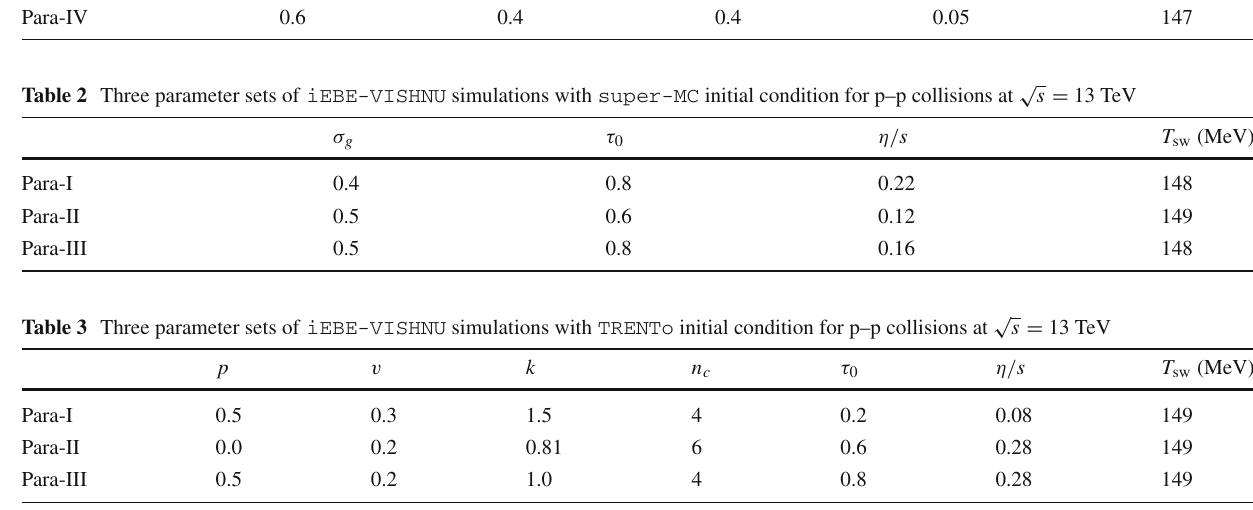
Table 2 Three parameter sets of iEBE-VISHNU simulations with super-MC initial condition for p–p collisions at